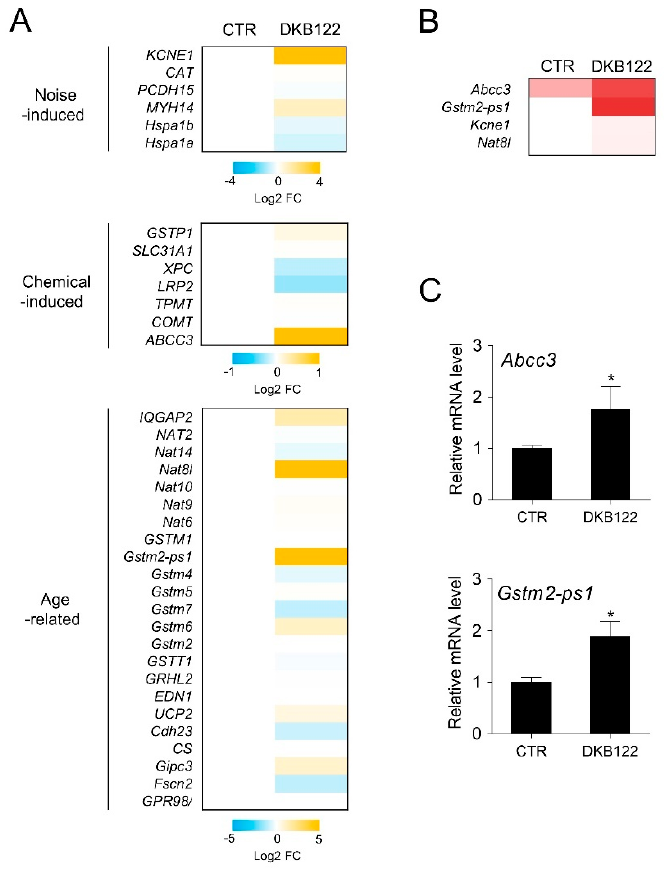
Figure 4. E ff ects of DKB122 on the expression of genes related to noise-, chemical, and age-induced hearing loss. ( A ) Heat map of genes associated with hearing loss, noise-induced, chemical-induced, and age-related hearing loss. ( B ) FPKM values of genes changed by DKB122 treatment. ( C ) mRNA levels of Abcc3 and Gstm2-ps1 were validated by RT-qPCR. HEI-OC1 cells were treated with DKB122 (25 µ g / mL) for 24 h. Isolated RNA was quantified by RT-qPCR. mRNA levels were normalized to 18S rRNA. Abcc3 , ATP Binding Cassette Subfamily C Member 3; Gstm2-ps1 , Glutathione S-transferase mu 2 (muscle), pseudogene 1. The results are presented as mean ± SD ( n = 3, * p < 0.05).